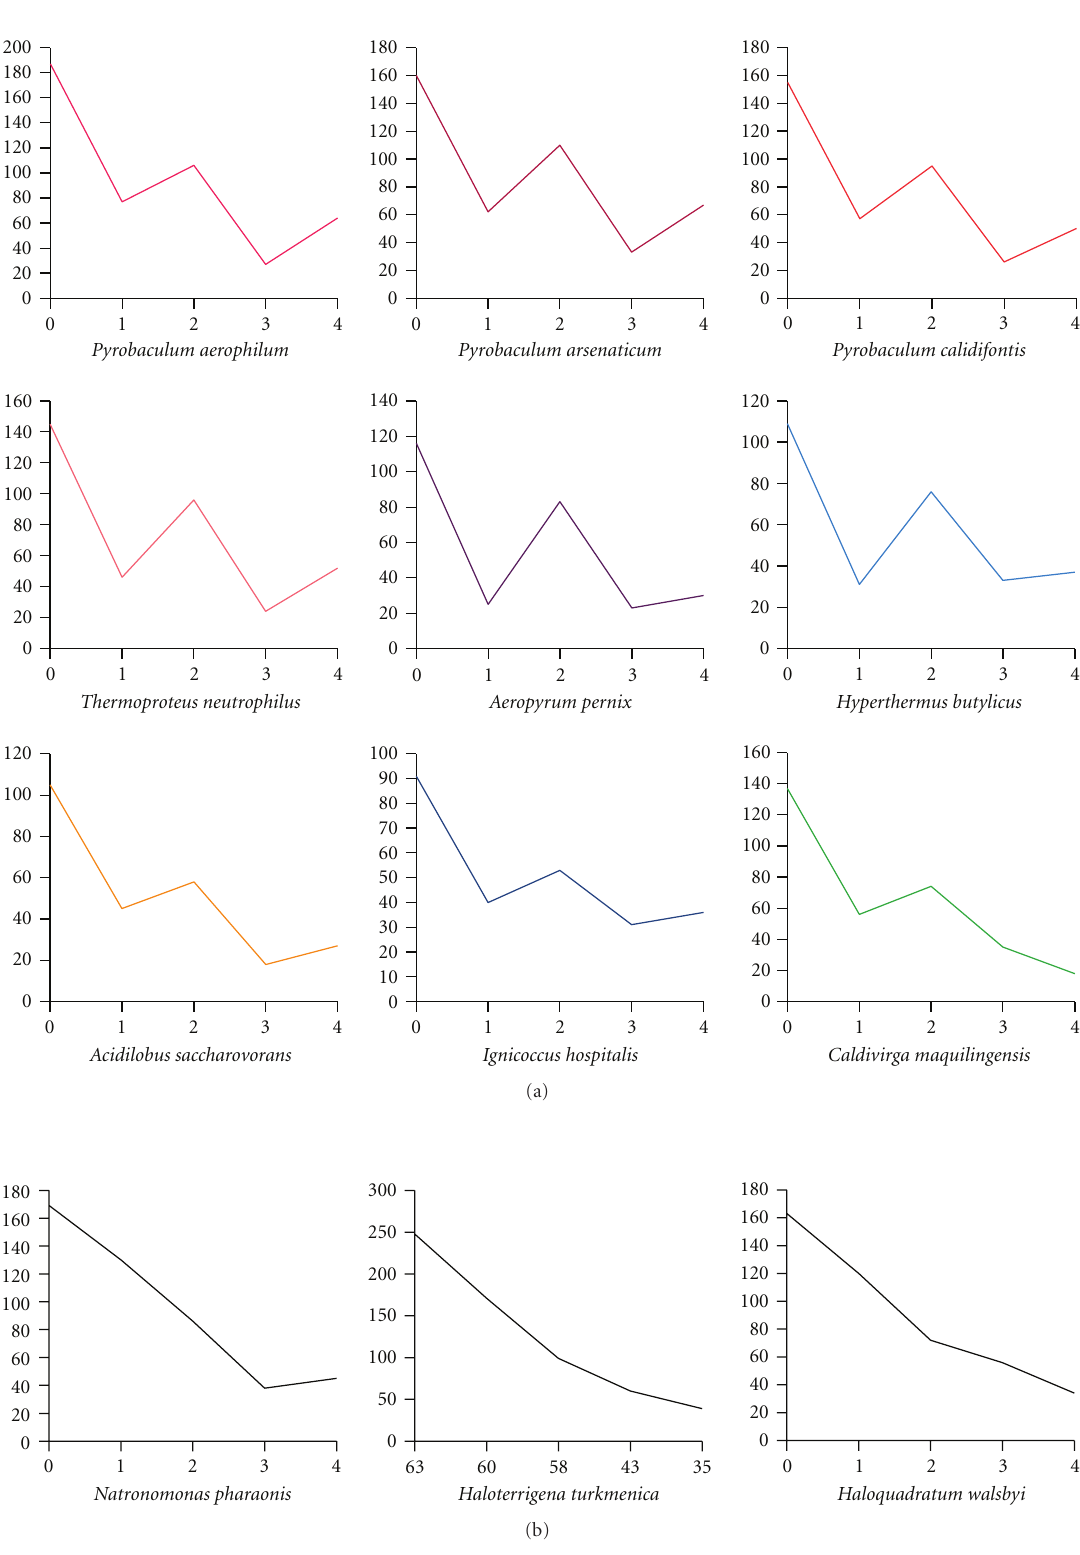
Figure 1: A preference for an even versus odd number of cysteines in proteins from thermophilic archaea. The dataset used for these plots consists of proteins with sizes ranging from 150 to 200 amino acids, the expected trend being more apparent for this class of proteins. (a) Numerous hyperthermophilic and thermophilic archaea show a clear propensity for even numbers of cysteine residues. This trend suggests an abundance of disulfide bonds. Nine examples are shown. (b) Selected nonthermophilic species (all halophiles) are shown as controls. In these cases, the plotted lines are nearly monotonic, indicating an absence of significant disulfide bonding in the